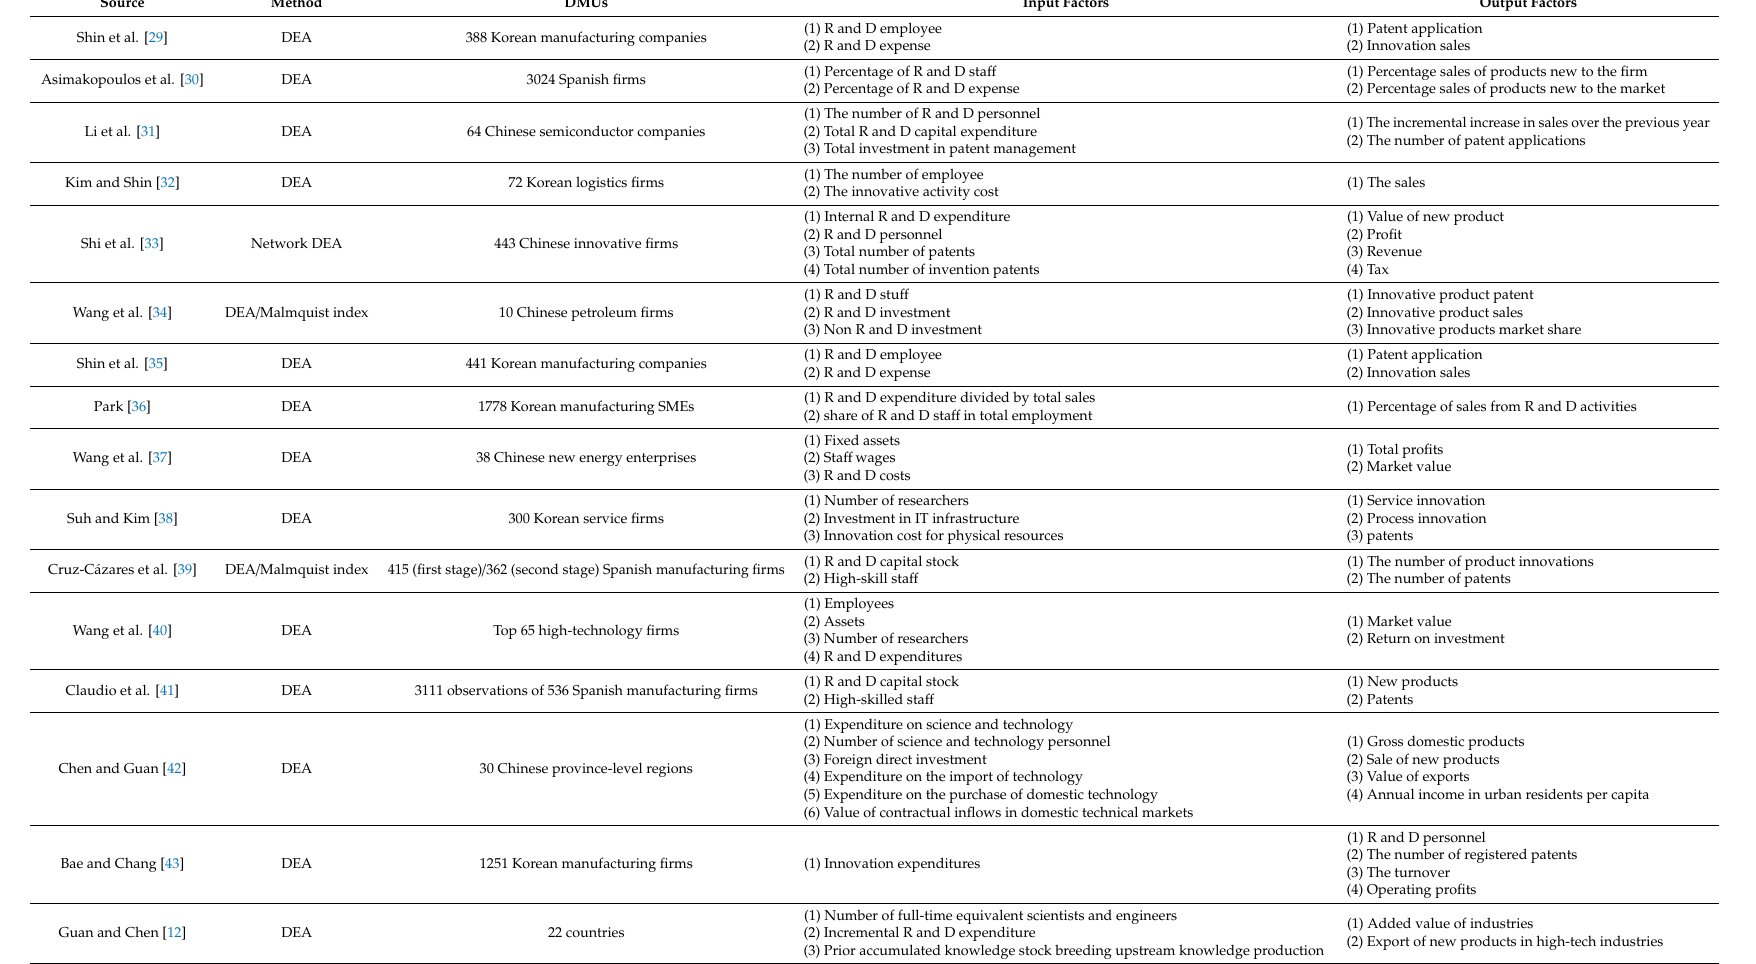
Table 1. Studies on innovation e ffi ciency (adopted from Shin et al.